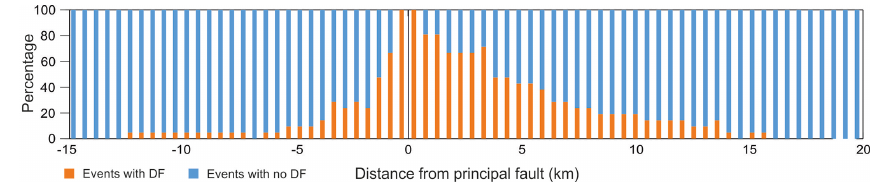
Figure 4. Percentage of earthquakes showing distributed faulting vs. no faulting for each distance class.